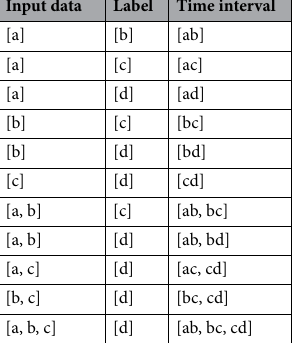
Table 3. The enhanced samples from a child’s or an adolescent’s 4 records (a, b, c, d). The time interval [ab] means the interval between record a and record b, in